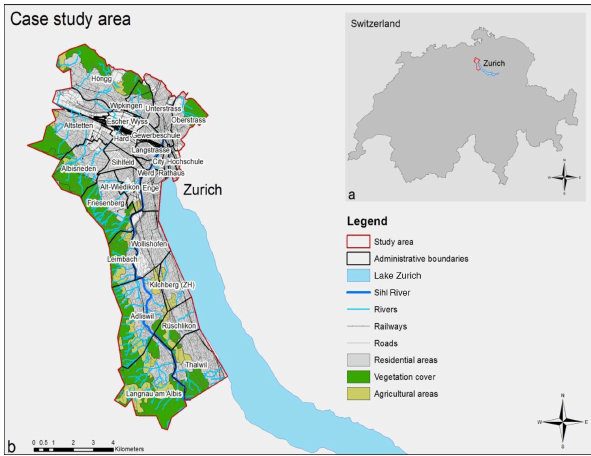
Figure 1. The case study area: (a) its location in Switzerland and (b) its main